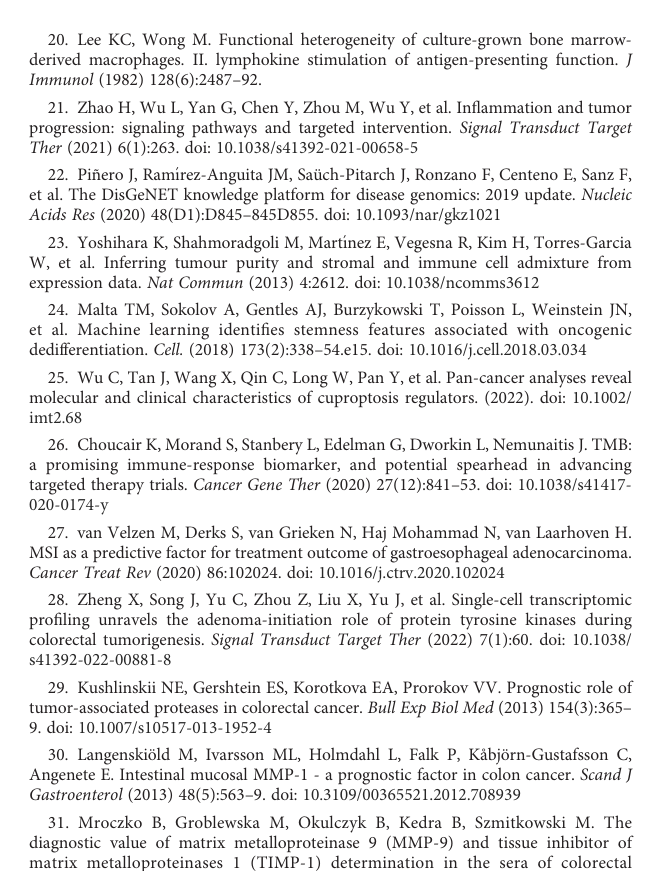
SUPPLEMENTARY FIGURE 4 Correlation analysis of the DCRGs with the stemness indices and microenvironment scores. (A, B) Heatmap showing the correlation of the seven DCGRs ’ expression with immune and stromal scores. (C, D) Heatmaps showing the correlation of the DCRGs ’ expression with stemness indices (DNAss and RNAss) in diabetes-in fl ammation-cancer-network TCGA cancer types. DNAss: DNA methylation-based stemness score, RNAss: RNA-based stemness score. Red points represent a positive correlation, while blue points represent a negative correlation. SUPPLEMENTARY FIGURE 5 Correlations of the seven DCRGs with the immunomodulators, TMB and MSI. (A) CorrelationsbetweenexpressionofthesevenDCRGsandtumormutation burden (TMB) across cancers. (B) Correlations between expression of the